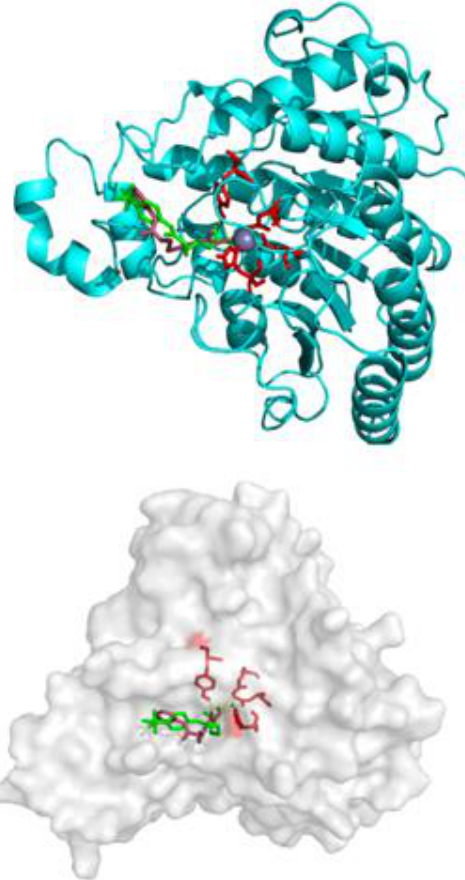
Figure 9. Overlay images of docked SF5-SAHA (green) and SAHA (purple) with HDAC2 in cartoon view (top image) and surface view (bottom image). The interaction of inhibitors with active site amino acids (red) and zinc ion (sphere) is highlighted.